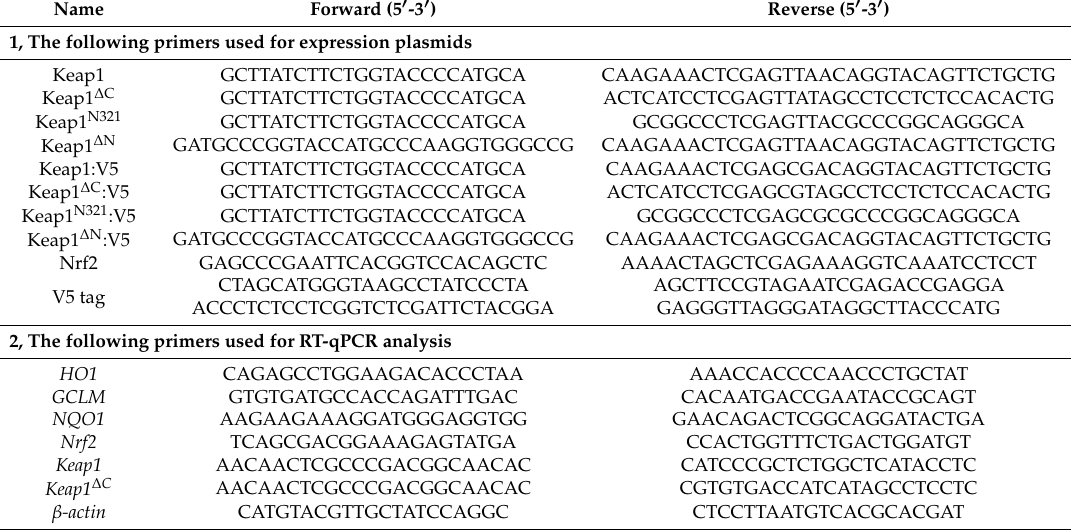
Table 1. Distinct paired primers used for expression constructs and RT-qPCR